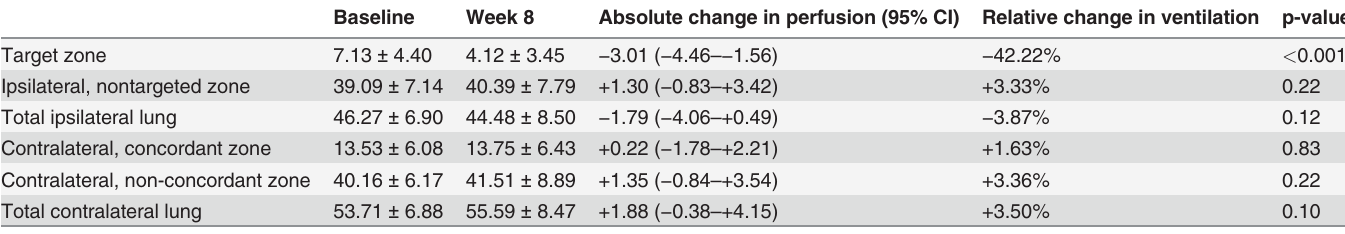
Table 3. Change in ventilation of single zones from baseline to eight weeks after EBV